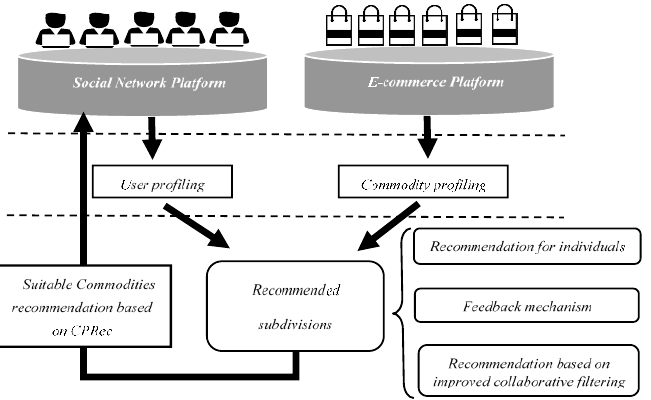
Figure 2. System model of the proposed cross-platform recommender system